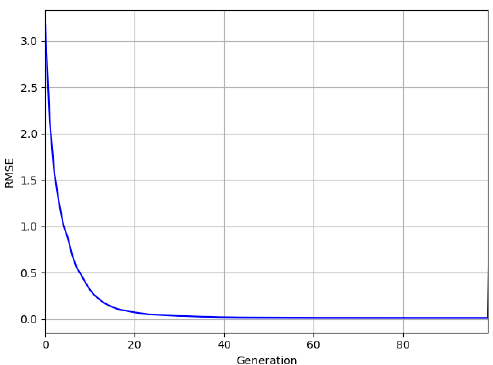
Figure 4. The evolution of average population fitness throughout the 100 iterations.